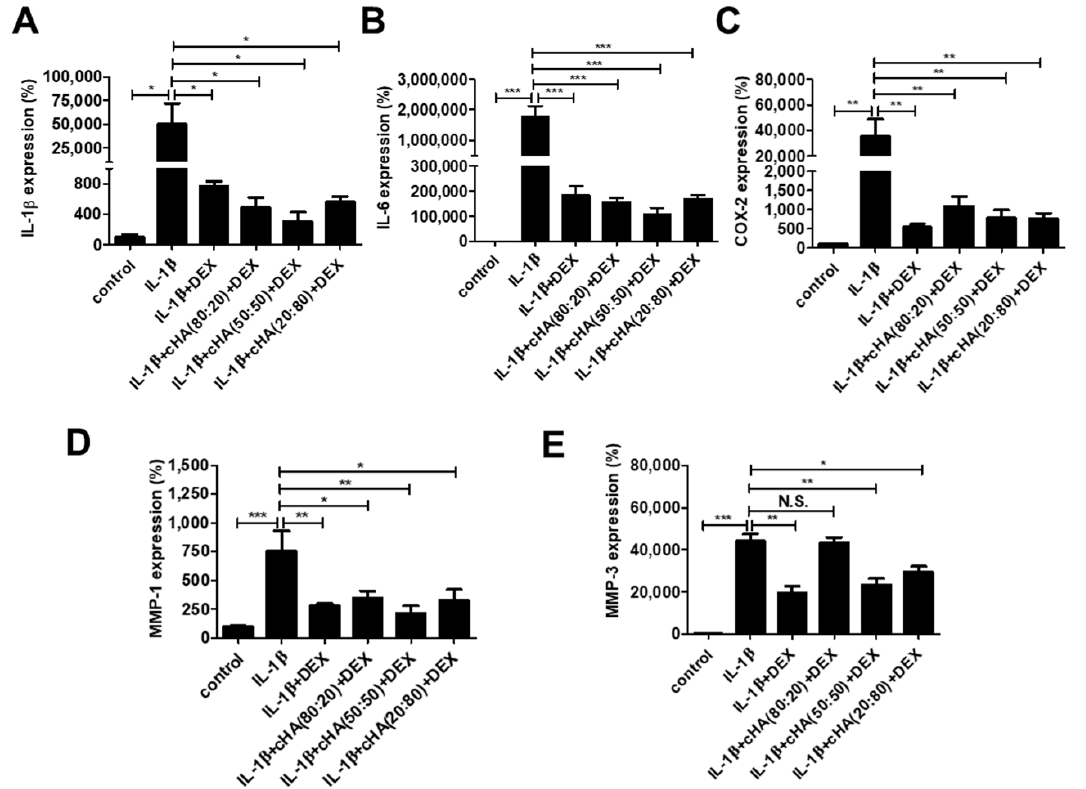
Figure 2. Effects of cHA with DEX in IL-1 -stimulated expressions of inflammatory mediators and matrix metalloproteinases (MMPs). Human primary tenocytes were treated with different formula- tions of cHA (cHA: linearized HA = 80:20, or 50:50, or 20:80, at the concentration of 2.5 mg/mL), DEX (100 µ M), and combinations of cHA with DEX (100 µ M) in response to IL-1 β (1 ng/mL) stimulation. Relative expressions of ( A ) IL-1 β ( B ) IL-6 ( C ) cyclooxygenase-2 (COX-2) ( D ) matrix proteinase-1 (MMP)-1, and ( E ) MMP-3 were determined by quantitative reverse transcription polymerase chain reaction (qRT-PCR). Values are the mean ± SEM ( n = 2 – 3). * p < 0.05, ** p < 0.01, *** p < 0.001.